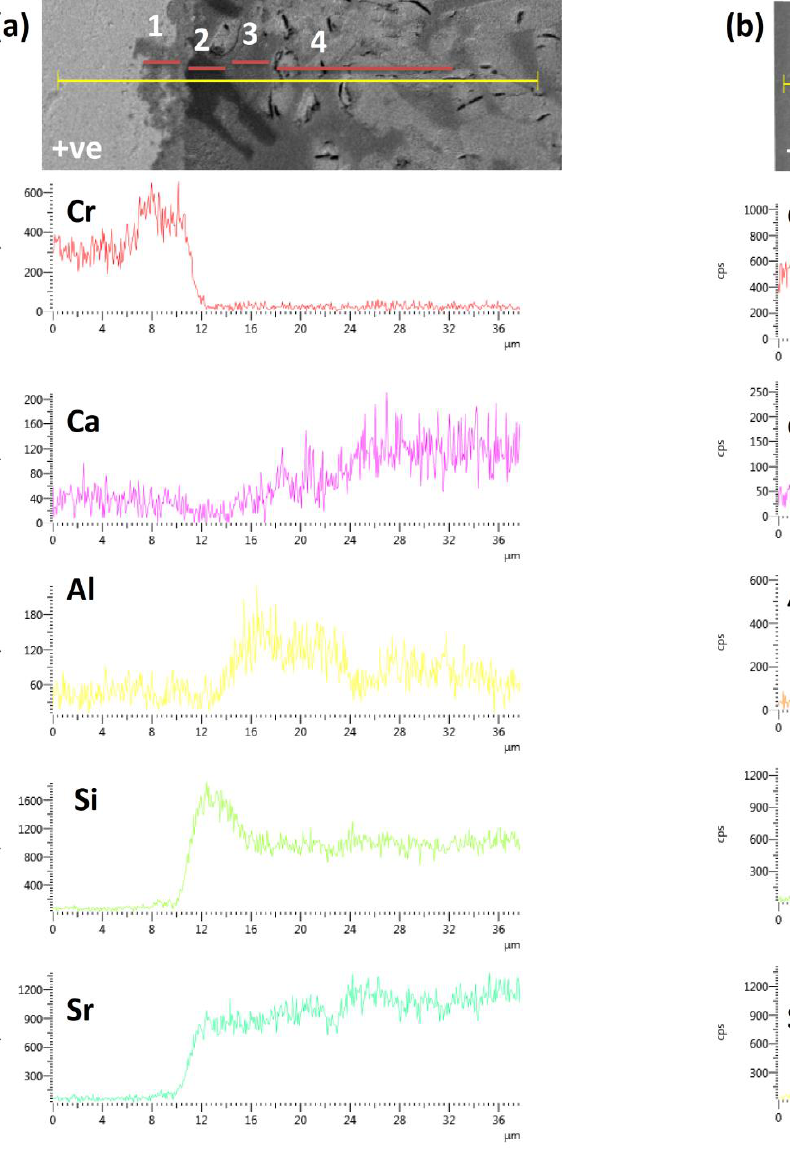
Figure 8. EDS line scan across ( a ) the air side of the positive polarized Crofer22APU/HJ14 glass- ceramic and ( b ) the air side of the negative polarized Crofer22APU/HJ14 glass-ceramic interfaces.